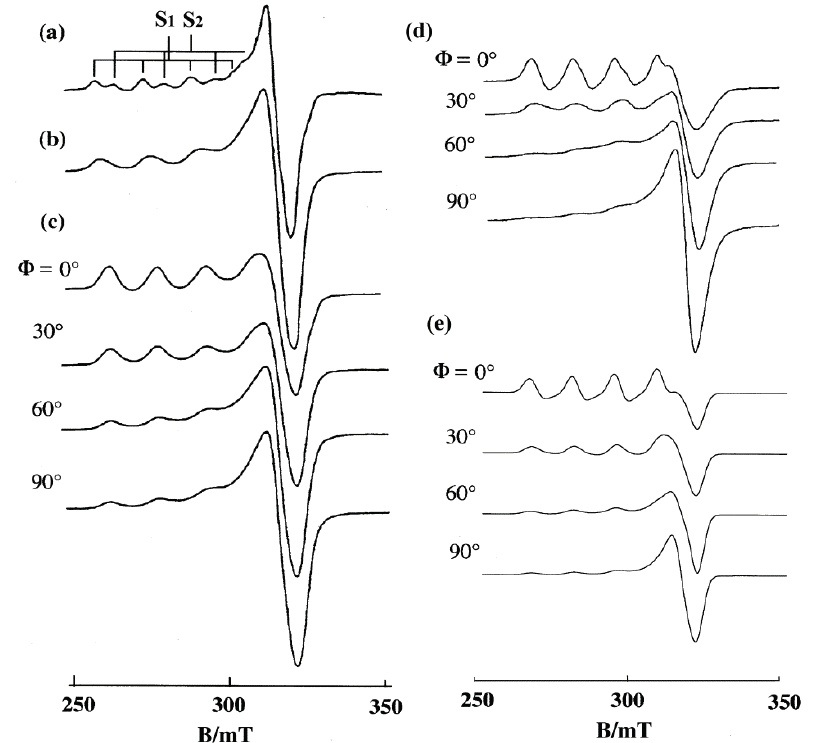
Figure 4. EPR spectra of [Cu(phen)(H 2 O) 3 ] 2+ ( a ) in frozen solution (20 mM, pH 7.0) at − 150 °C, S : g || = 2.317, A || = 0.0167 cm − 1 , S : g || = 2.260, A || = 0.0172 cm − 1 ; ( b ) in DNA pellet 1 2 at − 150 °C; and ( c ) on A-form DNA fibers at room temperature, [DNAbp]/[Cu(II)] = 25; ( d ) observed and ( e ) calculated EPR spectra of [Cu(phen)(H 2 O) 3 ] 2+ on B-form DNA fibers at room temperature. [DNA-bp]/[Cu(II)] = 25, [ G ]/[ I ] = 2. Other parameters used for = 30 G, species G : θ 0 = 30°, the simulation: species I : θ 0 = 6°, Δθ = 12°, Δ B || = 40 G, Δ (cid:1828) (cid:2884) Δθ = 30°, Δ B || = 40, Δ (cid:1828) = 40 G, [ G ]/[ I ] = 2. For both I and G , g || = 2.290, g ⊥ = 2.08, (cid:2884) = 0.0010 cm − 1 , A N || = 0.0010 cm − 1 , (cid:1827) = 0.0010 cm − 1 A || = 0.0154 cm − 1 , (cid:1827) (cid:2884) (cid:3015)(cid:2884)